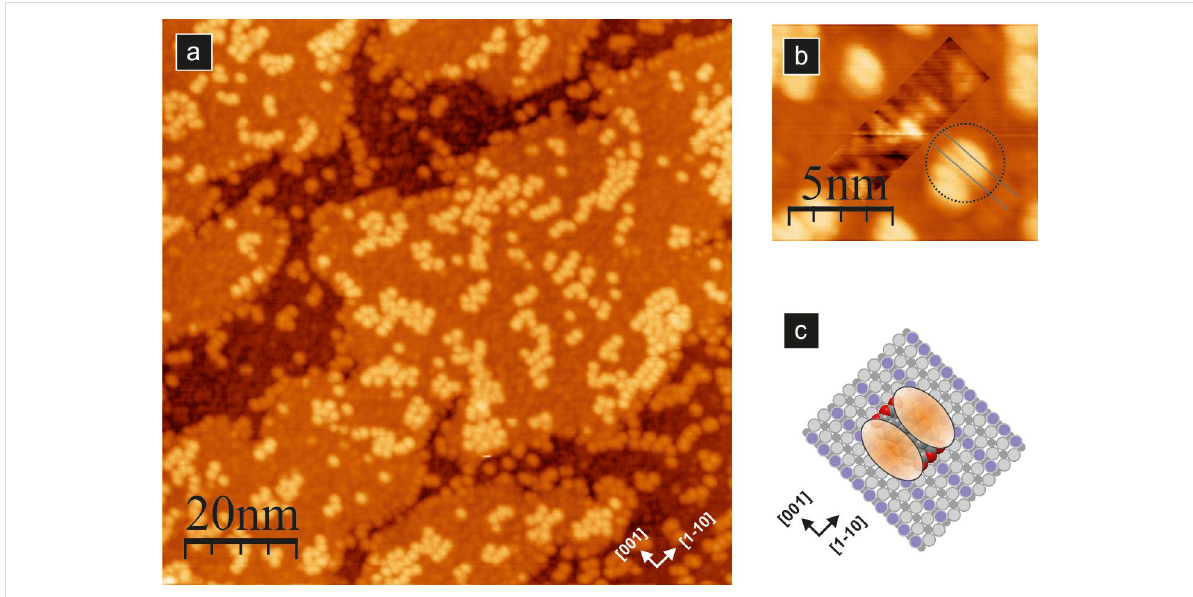
Figure 2: Empty-state STM image of a low coverage (<0.05 ML) of PTCDA molecules assembled on the TiO 2 (110) surface (a); (b) magnified image showing the position of the PTCDA molecule relative to the surface rows; for clarity, the image contrast inside the rectangle is adjusted to improve the visibility of surface reconstruction rows, and a single molecule STM image (two lobes) is marked with a dashed circle. (c) The structural model of the PTCDA molecule on the surface, where two ellipses mimic the STM appearance of a single molecule; all images acquired with 2 pA tunnelling current and 2.0 V bias